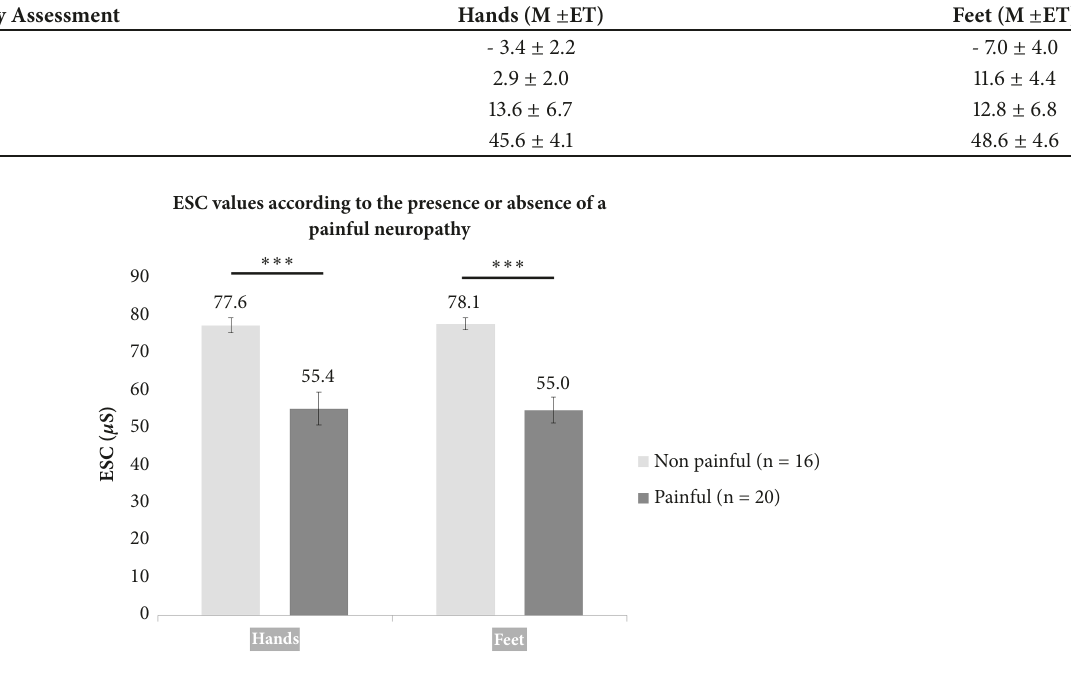
Figure 2: ESC values measured on hands and feet according to the presence or absence of a painful neuropathy. ESC values were lower in neuropathic patients with painful symptoms than in patients without painful symptoms: 55.4 ± 19.7 vs 77.6 ± 7.9 𝜇 S ( p = 0.0003) and 55.0